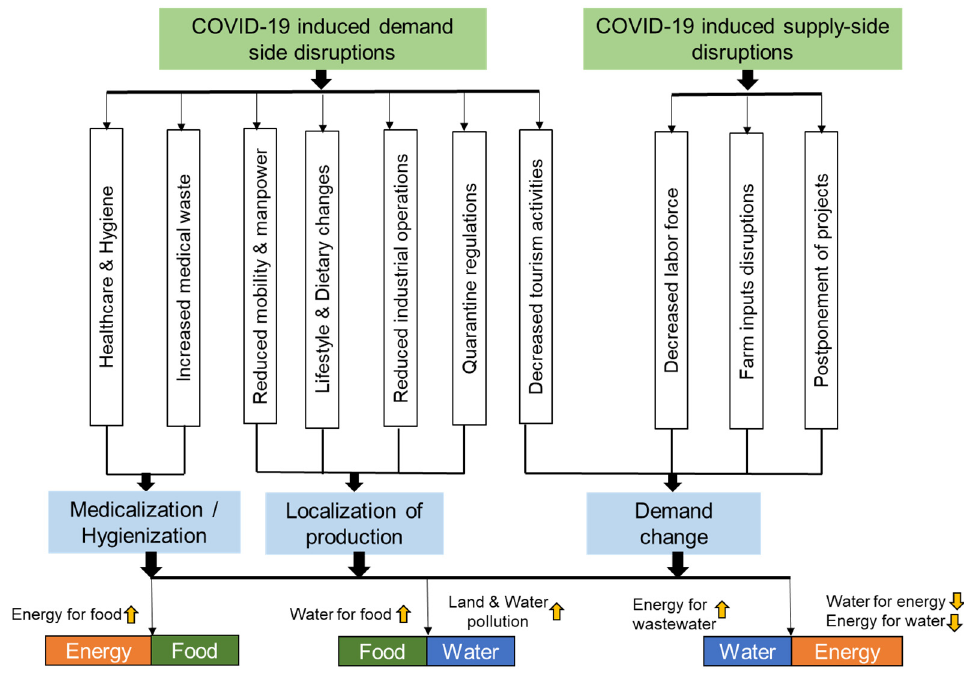
Figure 2. Implications of COVID-19 on the FEW nexus (image source: modified from [26]).